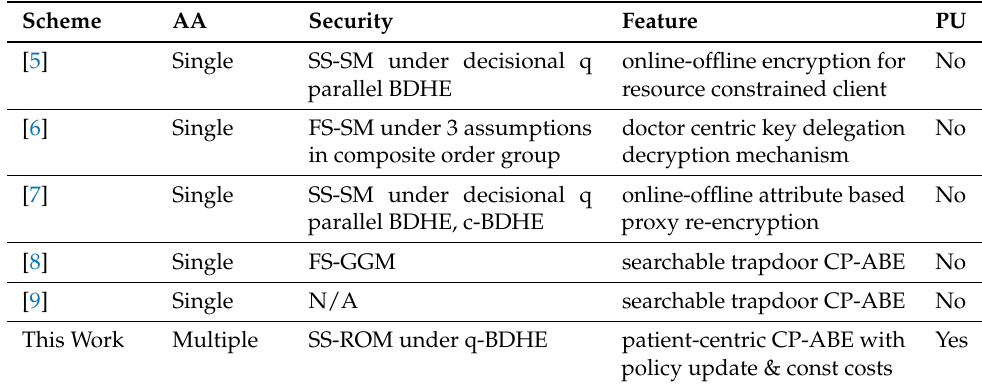
Table 1. Applications of CP-ABE schemes in